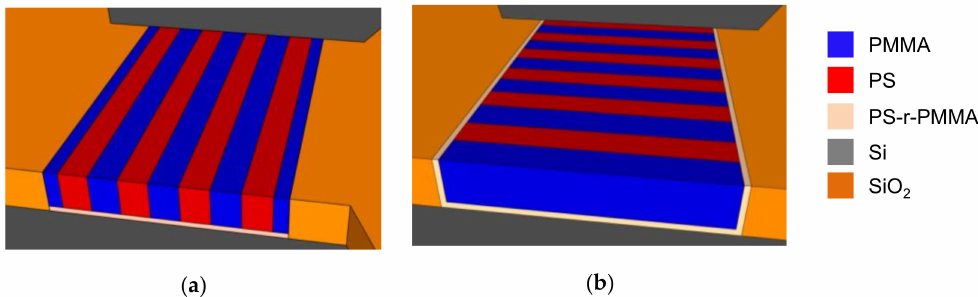
Figure 5. Graphoepitaxy of lamellar PS-b-PMMA within silicon oxide trenches. ( a ) If the bottom of the trench is neutral, but walls are a ffi ne to one block, vertical lamellae self-assemble parallel to the walls; ( b ) if walls and bottom are neutral, vertical lamellae self-assemble perpendicular to the three surfaces.